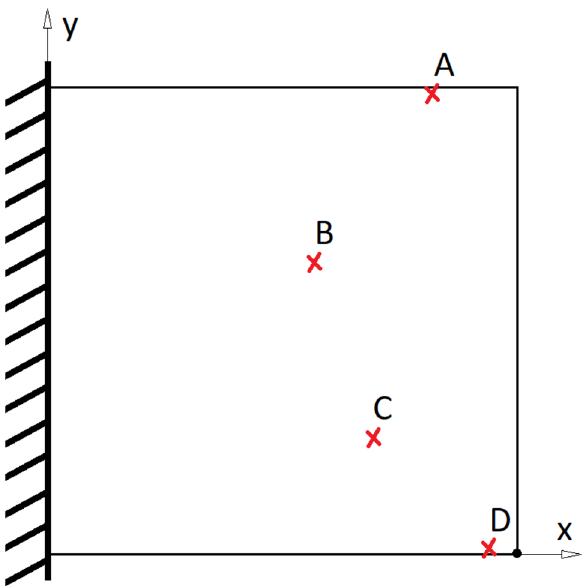
Fig. 9 Chosen grid highlighted on one section of the plate where all measurements are carried out. Each point on the grid corre- sponds to a calibration point. The four grating sensor positions also marked